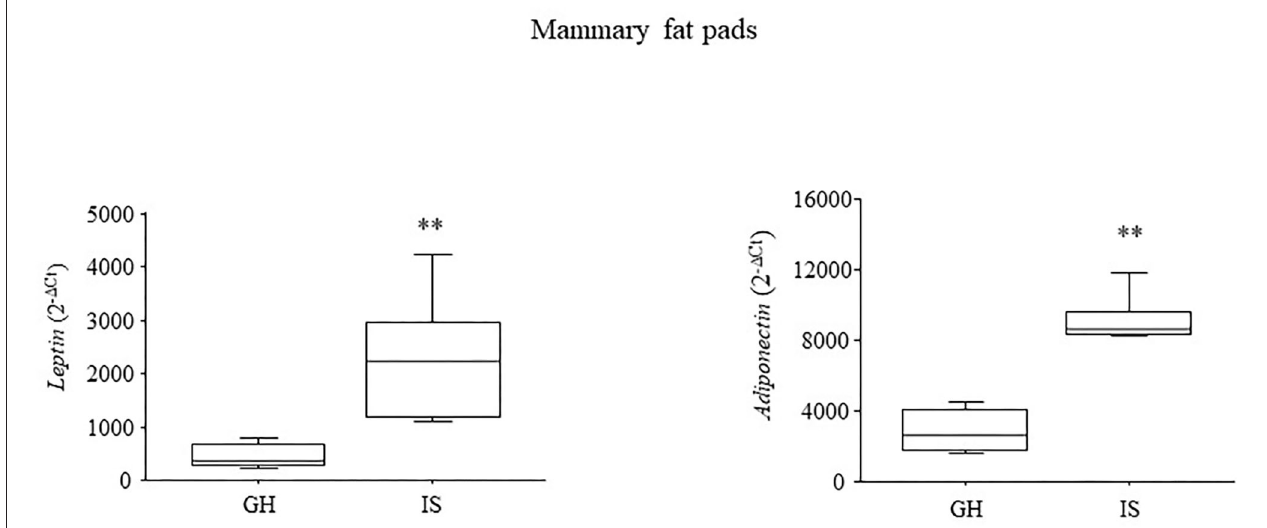
FIGURE 4 | Adipokines gene expression in the mammary fat pads. Chronic social isolation stress increased the levels of leptin and adiponectin in the MMTVNeuTg female mice. Data are presented graphically as means ± SEM box plots (observations outside the ranges are represented with dots outside the boxes). ** p < 0.01. Number of subjects: 4–5 within each experimental